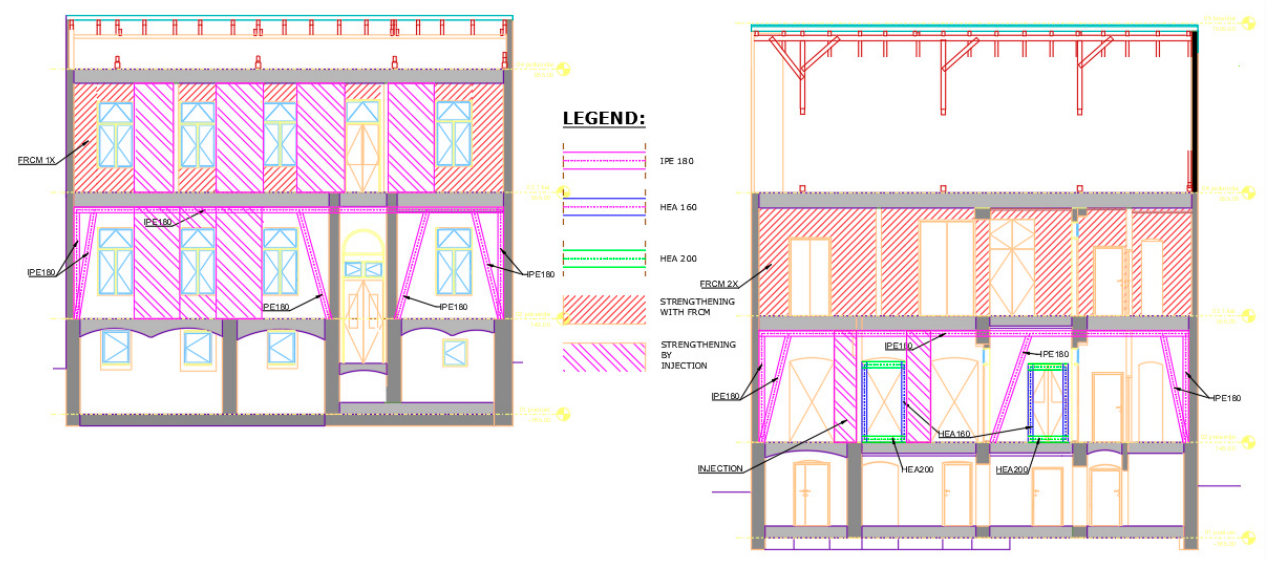
Figure 19. Strengthening measures of the walls at the ground floor level.